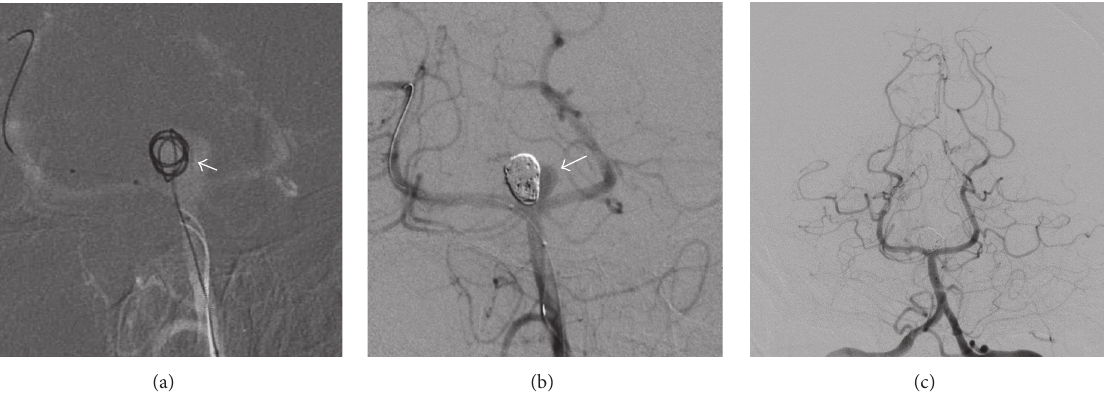
Figure 2: Microcatheter positioned within the right sided aneurysmal compartment, with the coil loops abutting the septum (a). Right sided chamber complete occlusion with patent left chamber (arrow) with coils constrained by the septum (b). Complete coil embolisation of both compartments